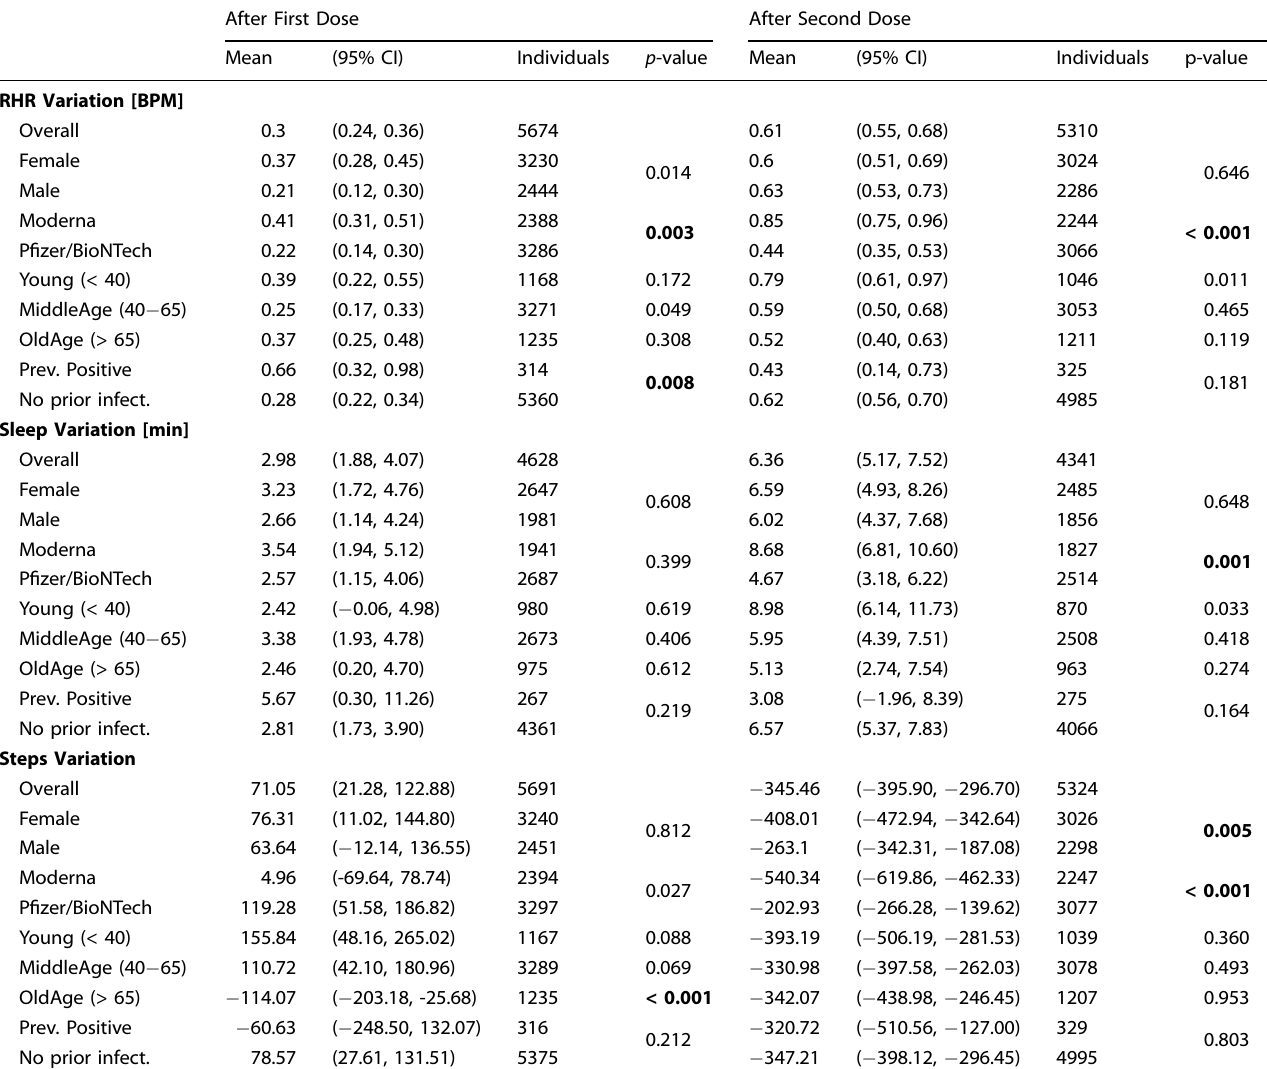
Table 1. Mean changes in RHR, sleep and activity metrics with respect to the individual baseline in the day of vaccination and the following 4 days, for fi rst and second dose. After First